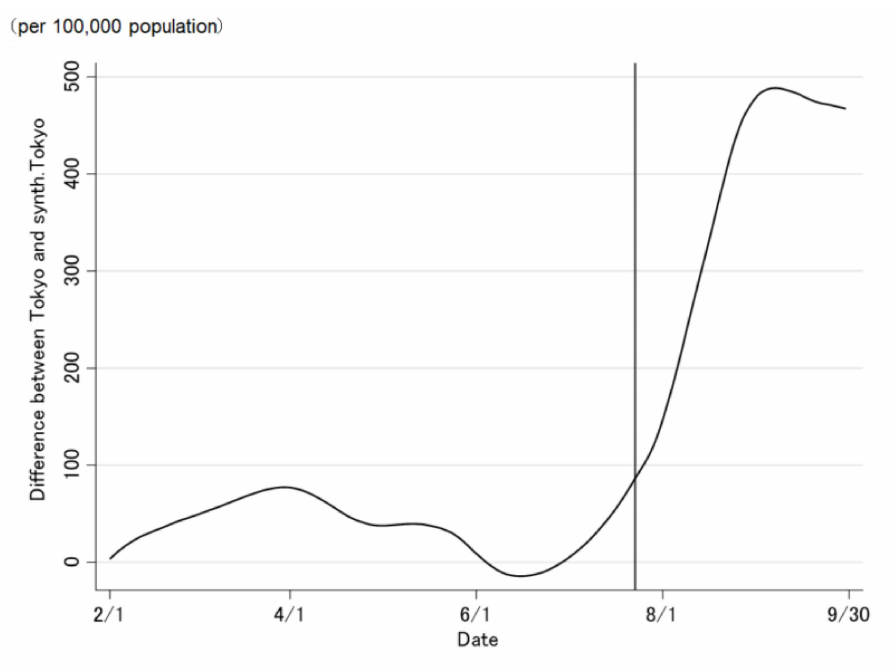
Figure 5. Difference in the cumulative daily number of newly confirmed COVID-19 cases between Tokyo and synthetic Tokyo, estimated using synthetic control